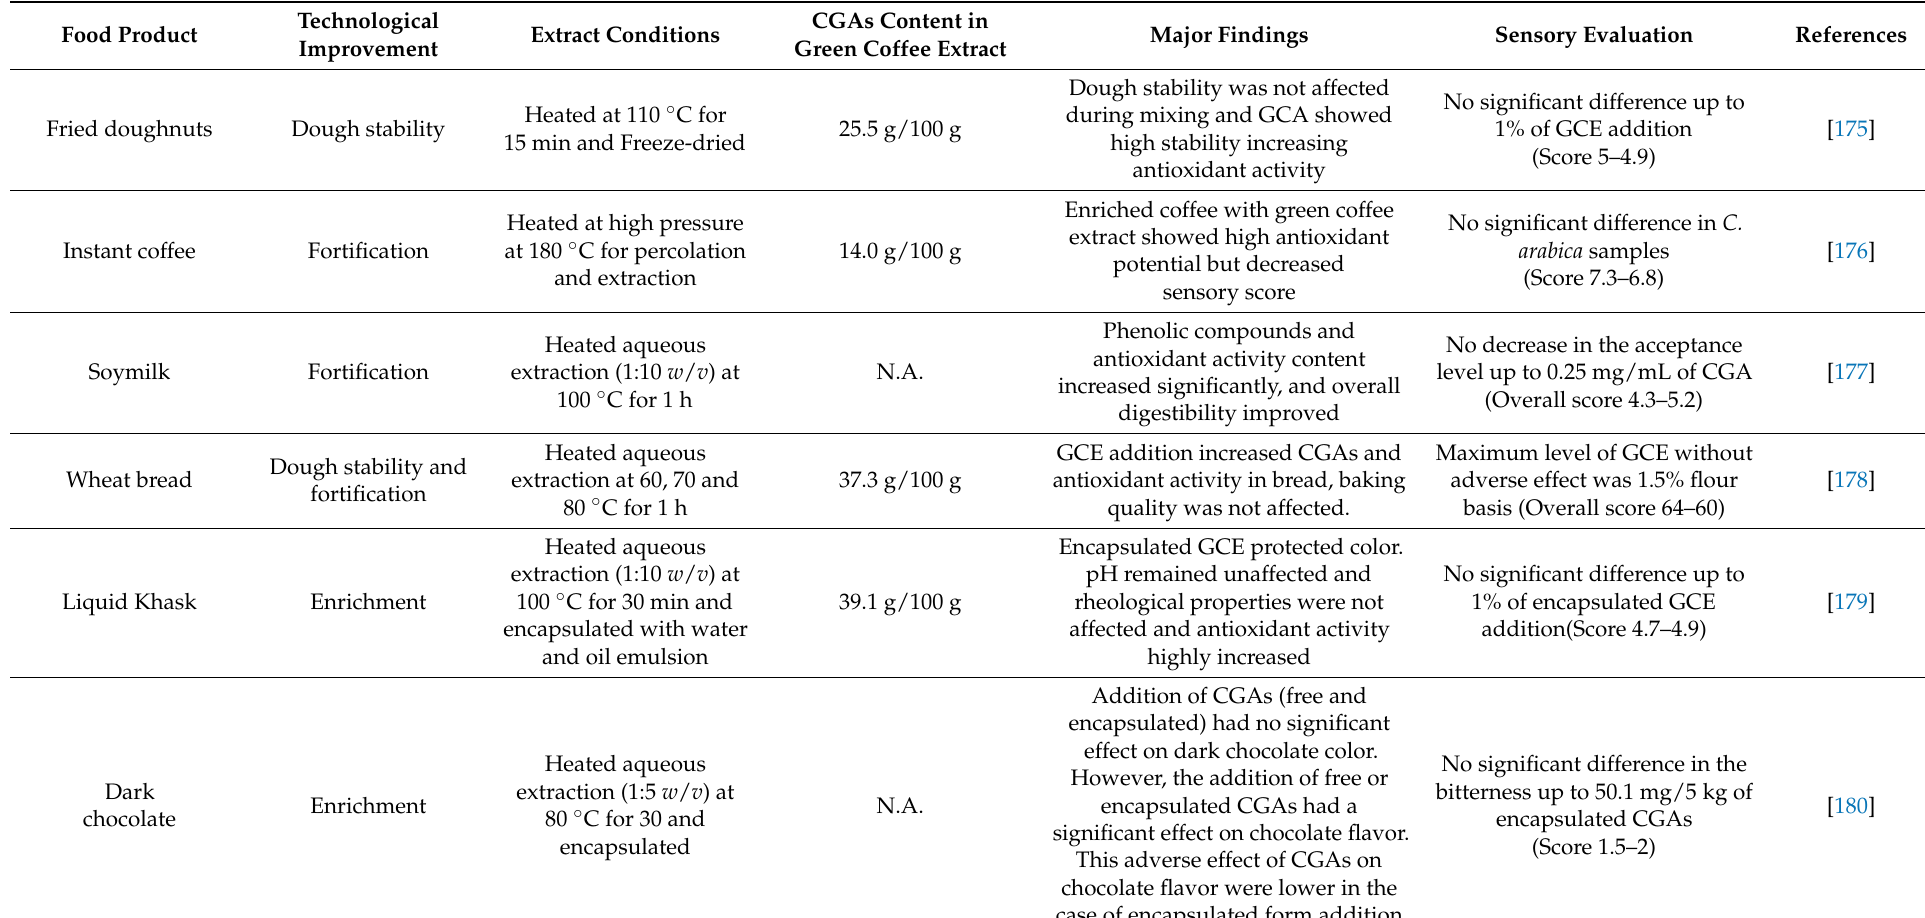
Table 2. Principal incorporation of coffee extracts with CGAs into food products a